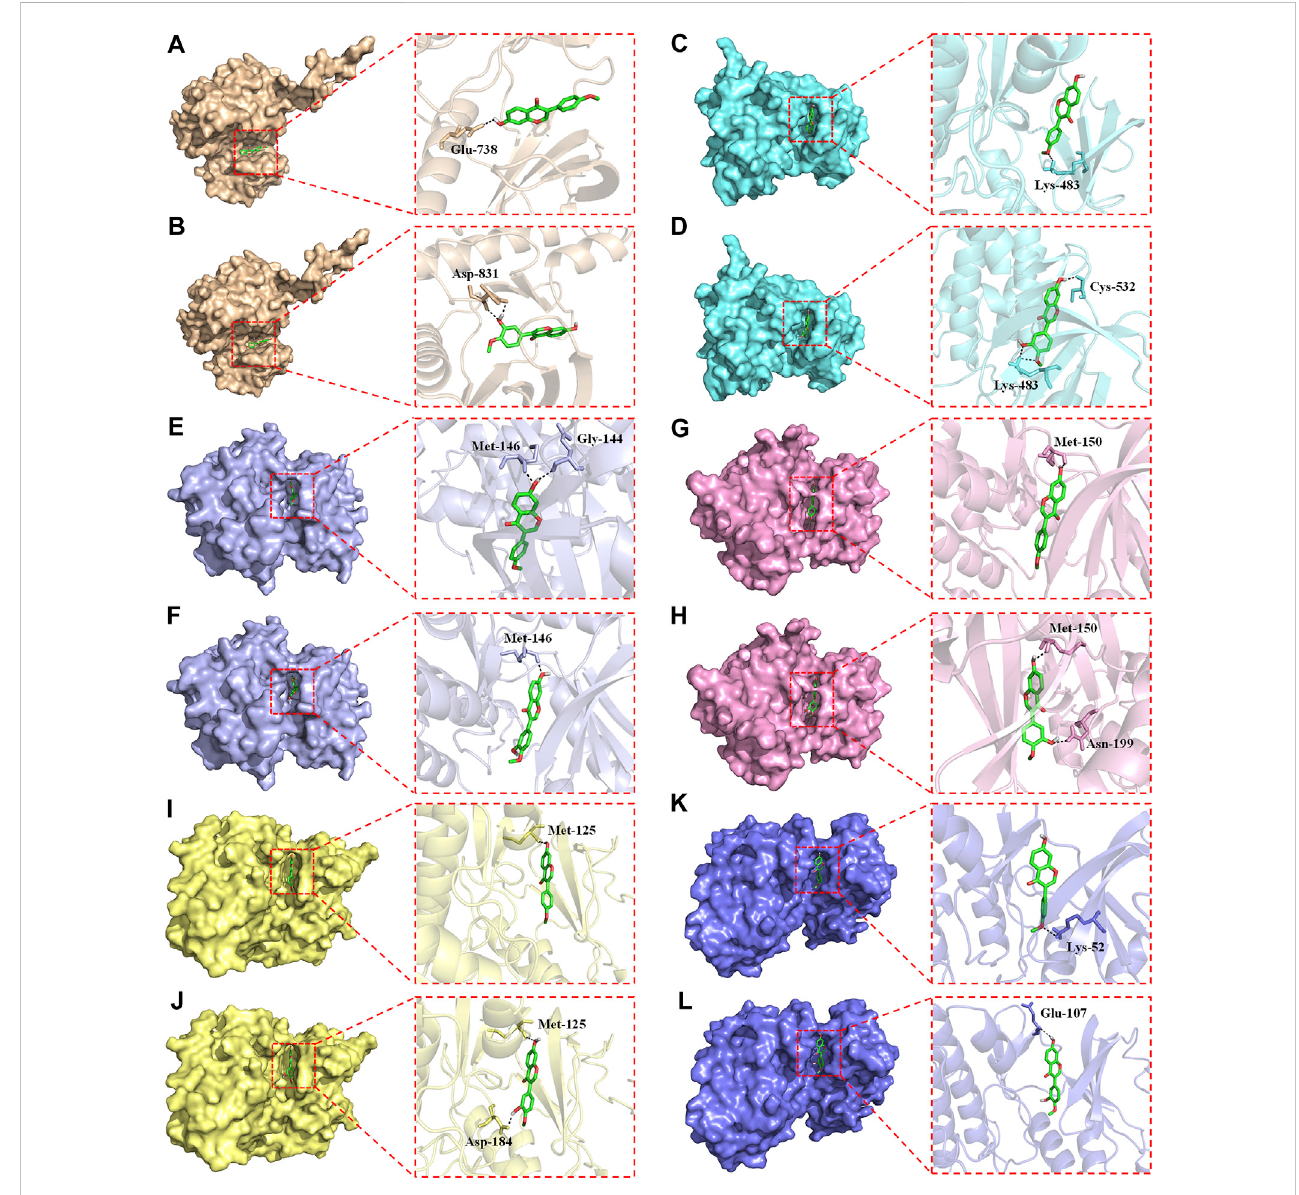
FIGURE 12 Pattern diagrams of molecular docking. FMNT-EGFR (A) . CS-EGFR (B) . FMNT-BRAF (C) . CS-BRAF (D) . FMNT-MEK1 (E) . CS-MEK1 (F) . FMNT-MEK2 (G) . CS-MEK2 (H) . FMNT-ERK1 (I) . CS-ERK1 (J) . FMNT-ERK2 (K) . CS-ERK2 (L) .